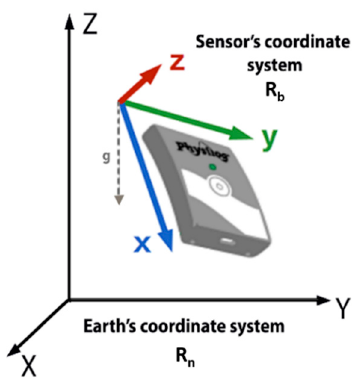
Figure 2. Earth and sensor’s coordinate systems.